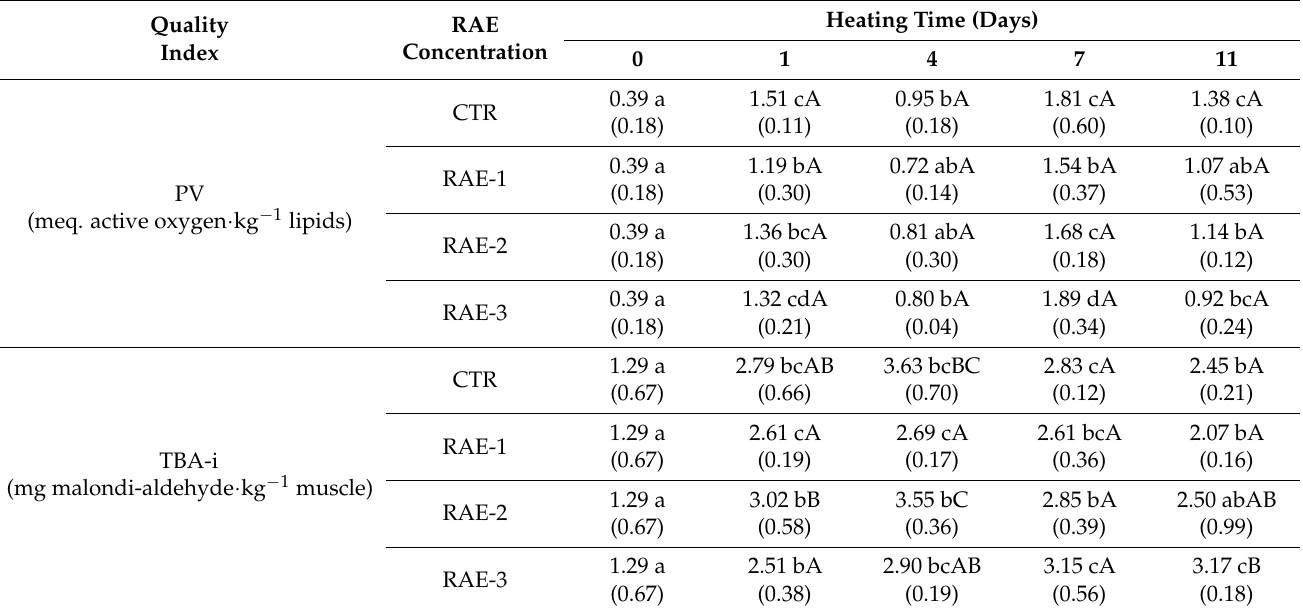
Table 2. The assessment of peroxide value (PV) and the thiobarbituric acid index (TBA-i) in fish muscle heated in the presence of red alga extract (RAE) *.